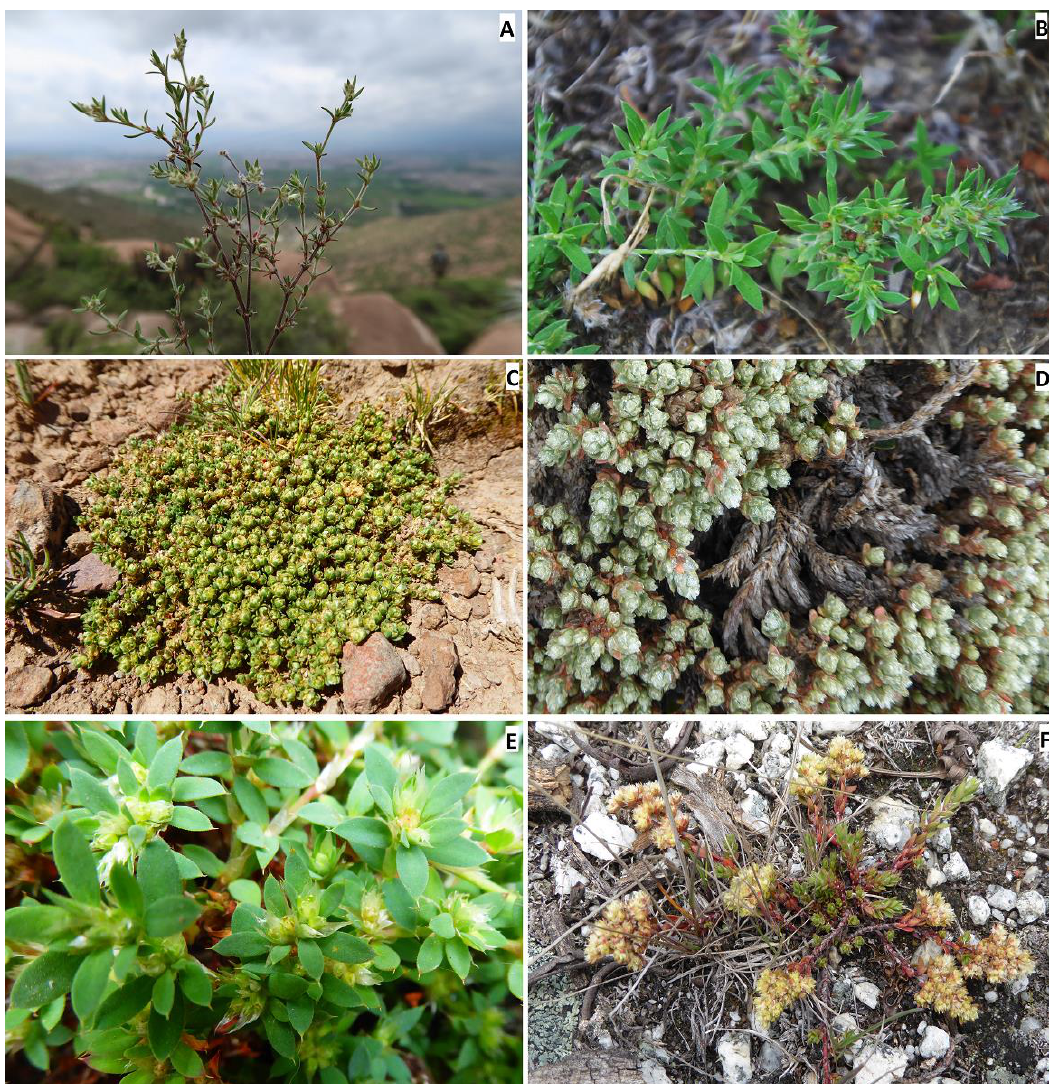
Figure 2. Habit images of different species of Paronychia occurring across the Andes. ( A ) Woody branch of the endemic P. arequipensis near El Batolito, Socabaya, Arequipa, 2300 m, ( B ) P. chilensis developing near Cerro La Campana, Valparaiso, Chile, 1000 m, ( C ) P. compacta subsp. compacta with characteristic mat-forming habit, near Tisco, Chivay, Colca Canyon, Caylloma, Arequipa, 4700 m, ( D ) P. compacta subsp. purpurea in Huascaran National Park, Ancash, Peru, 4600 m, ( E ) P. ellenbergii close-up, near Chincheros, Cusco, Peru, 3700 m, ( F ) P. libertadiana near Laguna Parón, in Huascaran National Park, Ancash, Peru, 4150 m. Photos: DBMT.